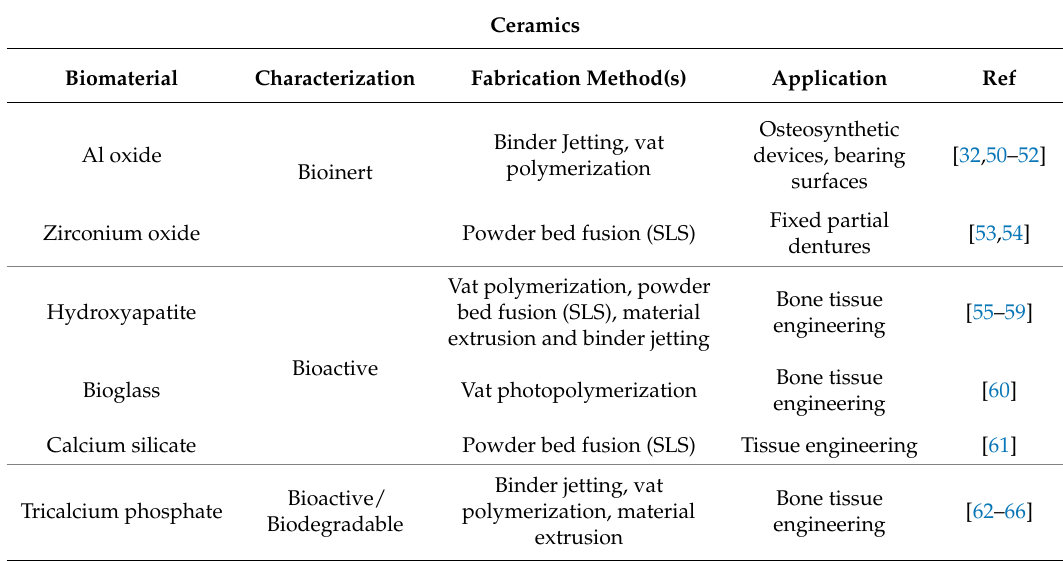
Table 1. Biocompatible ceramics. The table gives an example of biocompatible ceramics, their characterization, applications, and additive manufacturing